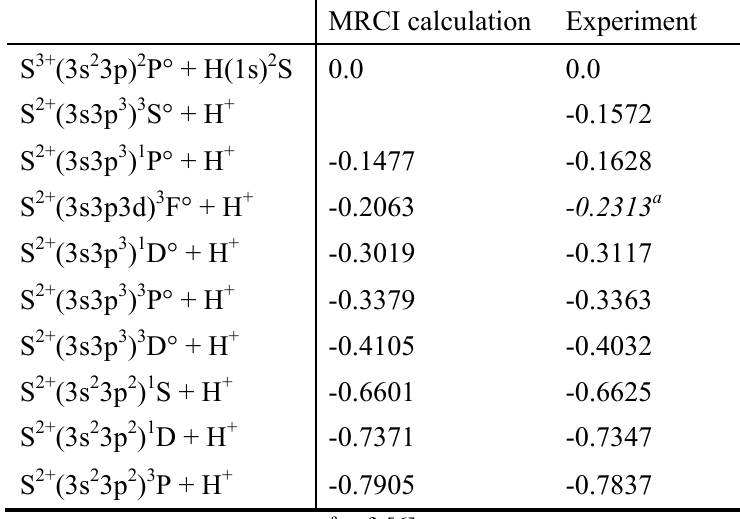
Table II : Comparison with experiment [17] for asymptotic energy levels (in